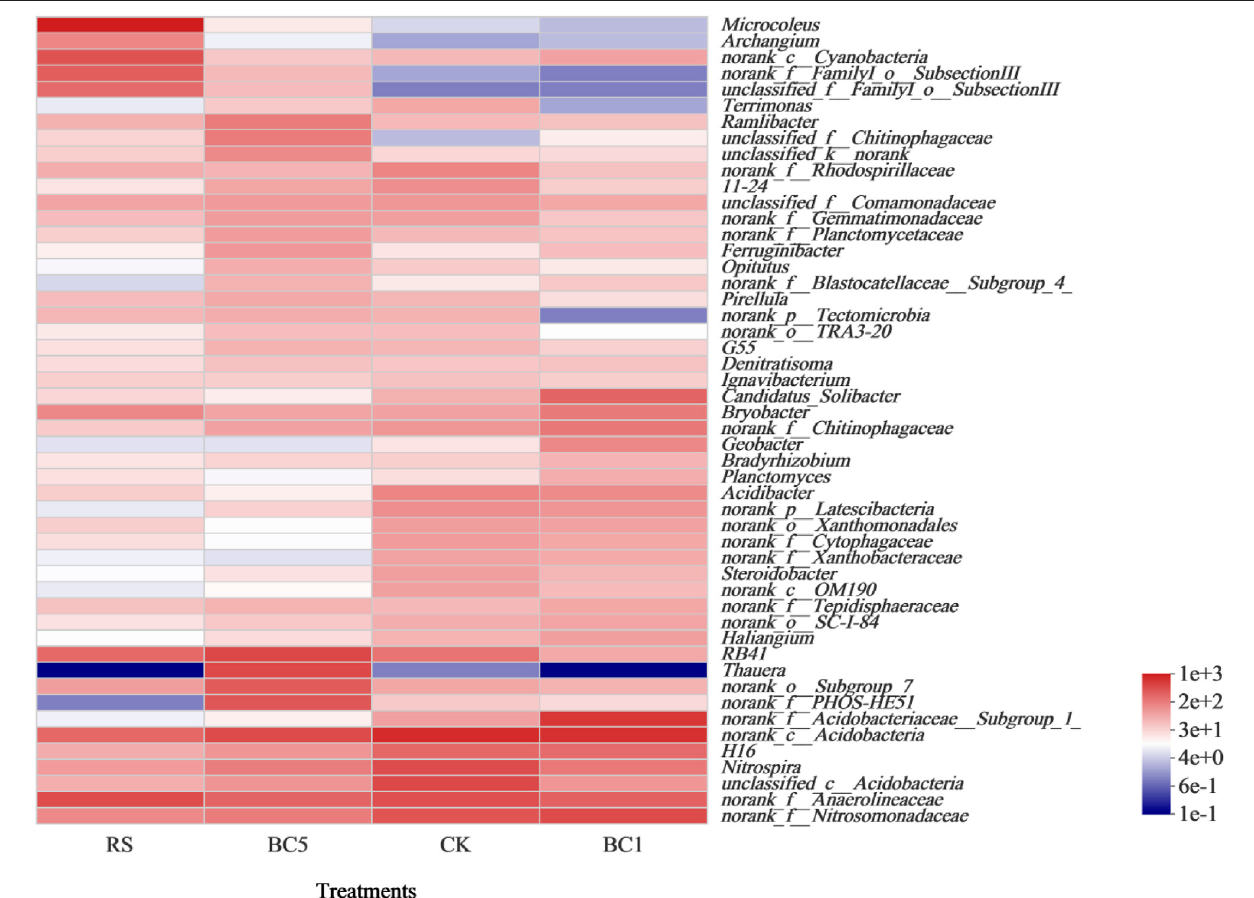
FIGURE 6 | The heatmap of soil bacterial community at the genus level in soils. CK: without biochar or rice straw; BC1: 2.25 Mgha − 1 biochar; BC5: 11.25 Mgha − 1 biochar; RS: 2.25 Mgha − 1 rice straw.